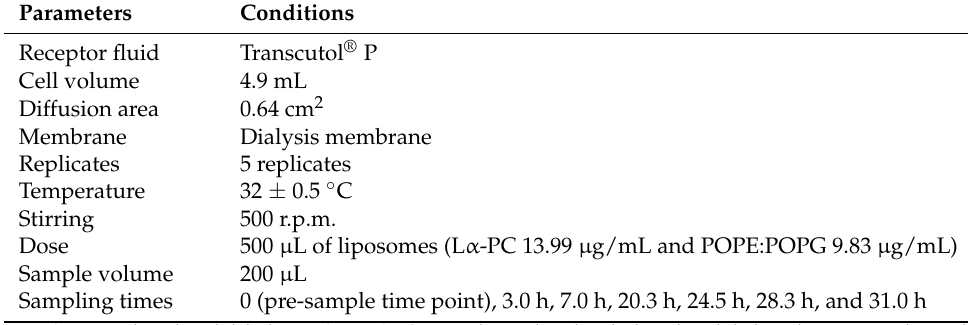
Table 1. Experimental conditions for the in vitro release